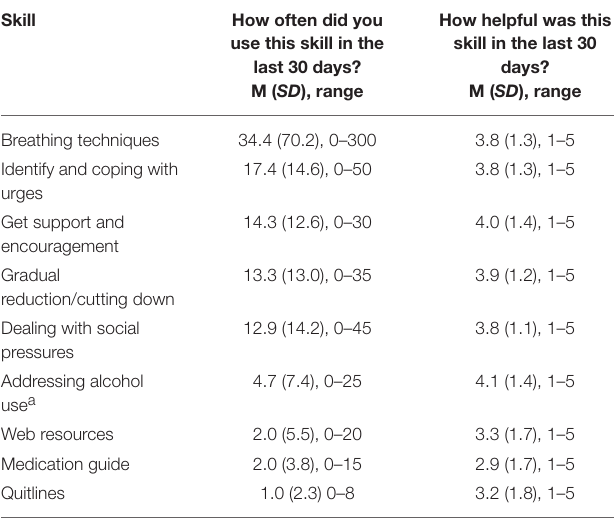
TABLE 2 | Utility of smoking cessation skills discussed in the brief counseling condition. Skill